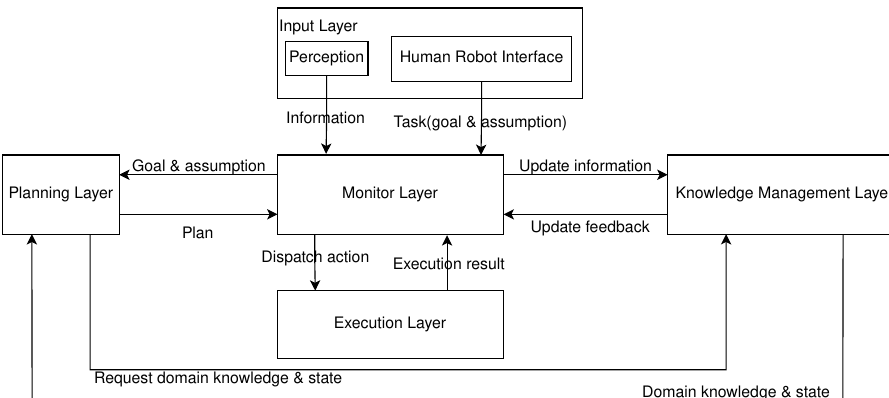
Figure 1. Framework